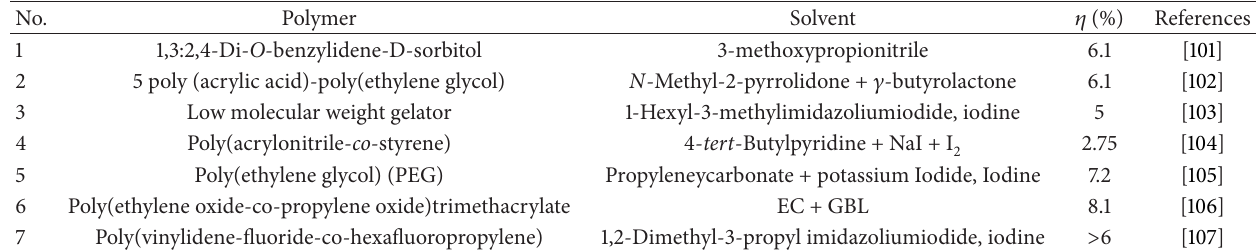
Table 6: Polymer electrolytes and their performance in DSSC